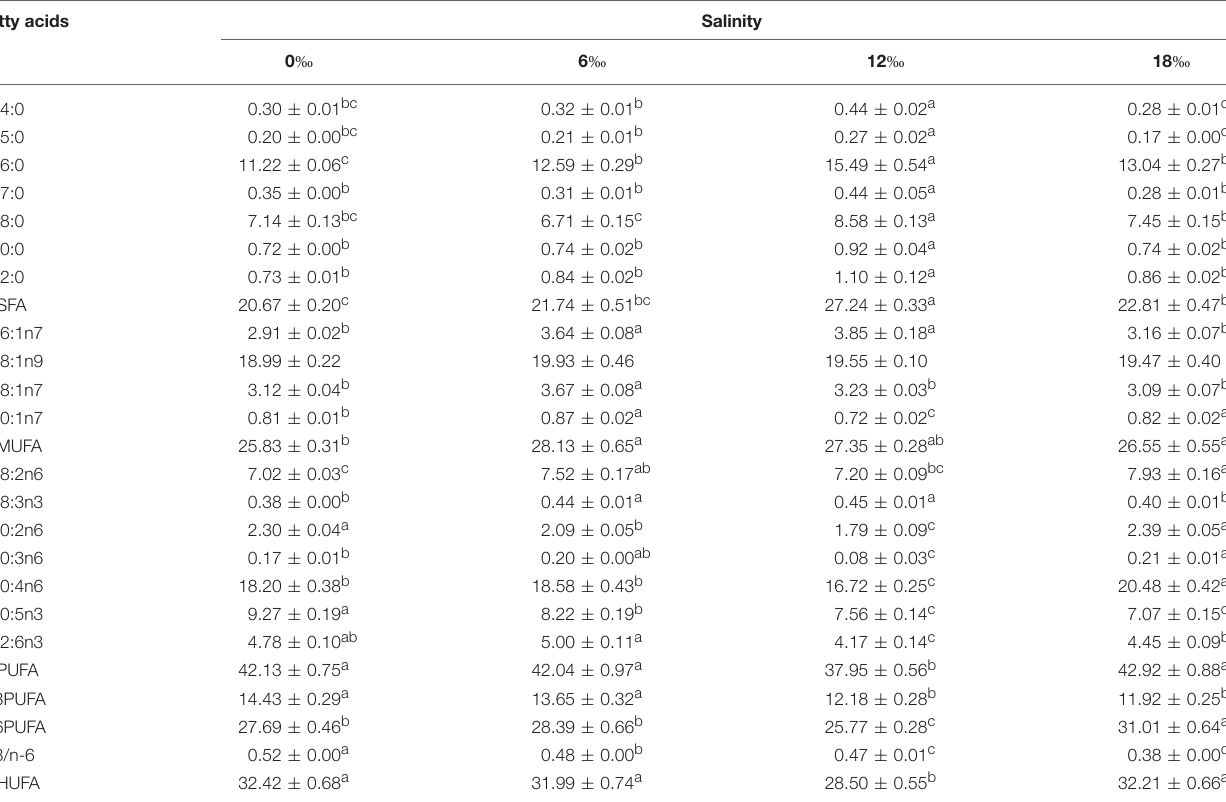
Data are presented as mean ± SE. Values within the same row with different letters indicate significant difference (P < 0.05). P SFA: total saturated fatty acid; P MUFA: total monounsaturated fatty acid; P PUFA: total polyunsaturated fatty acid; P HUFA: total highly unsaturated fatty acid.